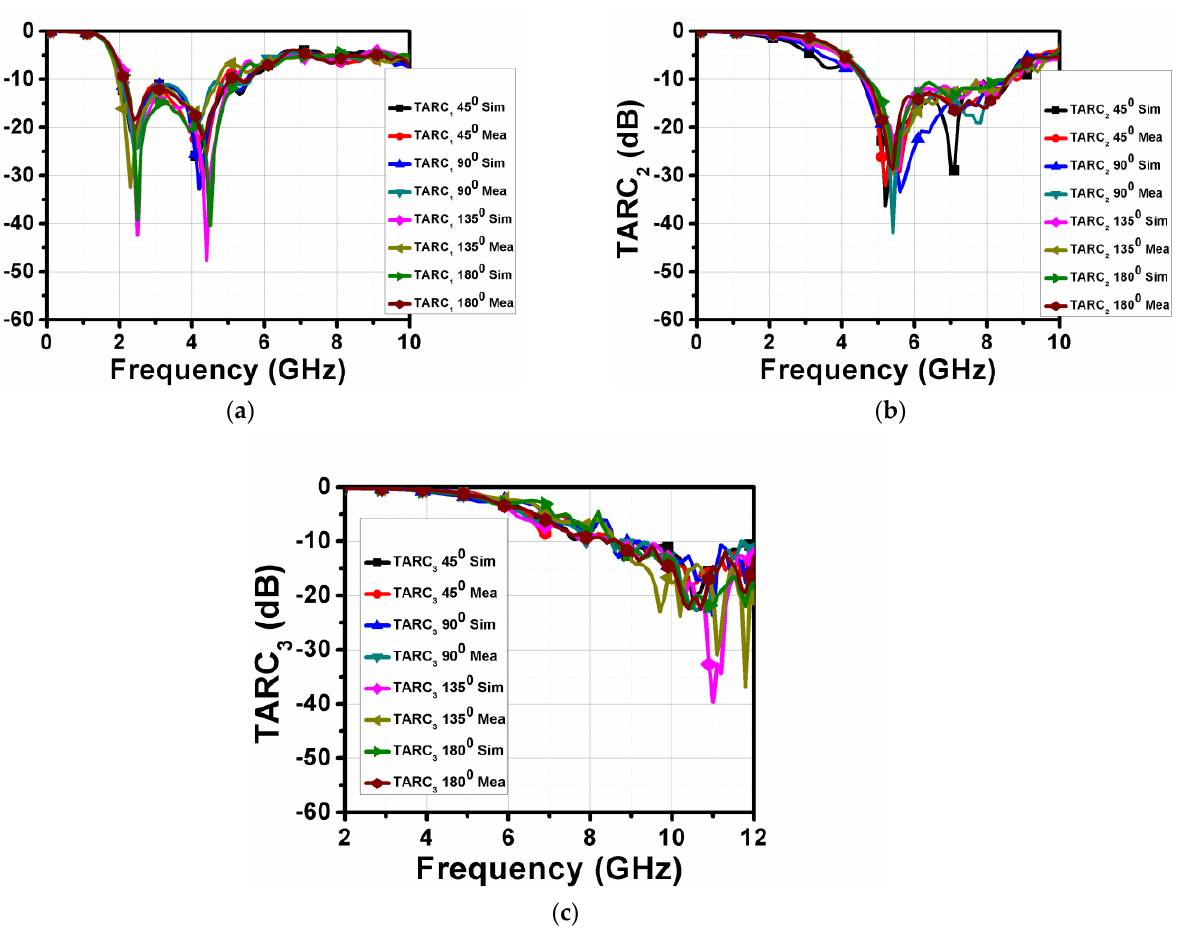
Figure 35. TARC of the 8-element communication antennas associated with ( a ) ports 2 to 9, ( b ) ports 10 to 17, and ( c ) ports 18 to 25.